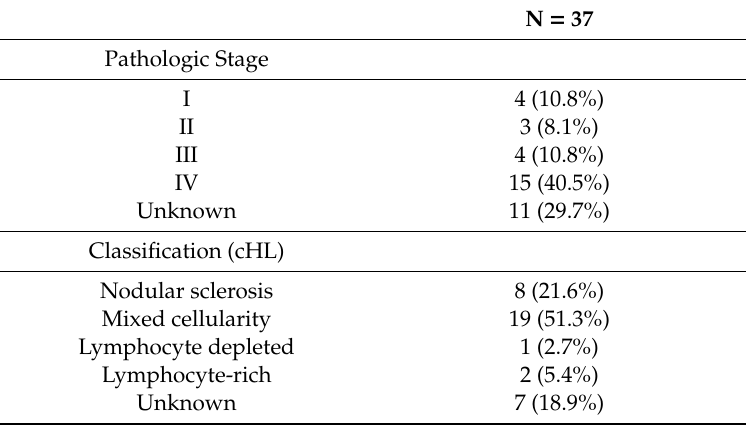
Table 2. World Health Organization classification of classical Hodgkin lymphoma.